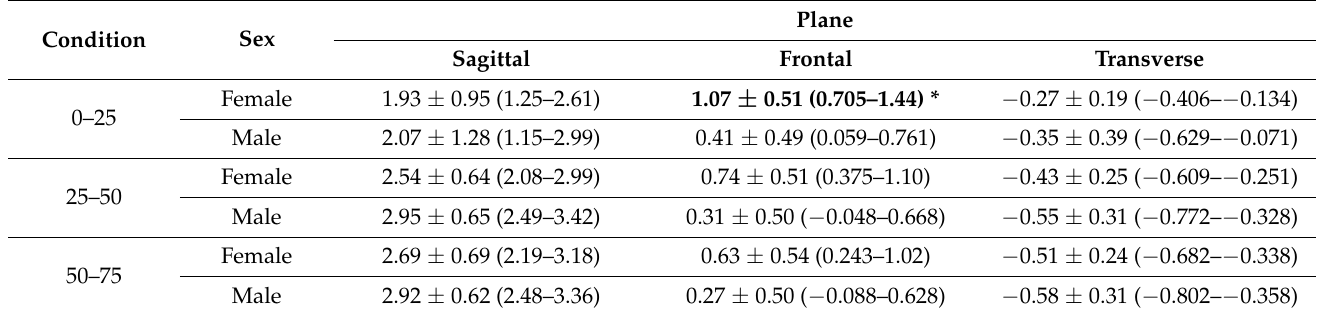
Table 3. Limb support moments (sex comparison) 50 ms.